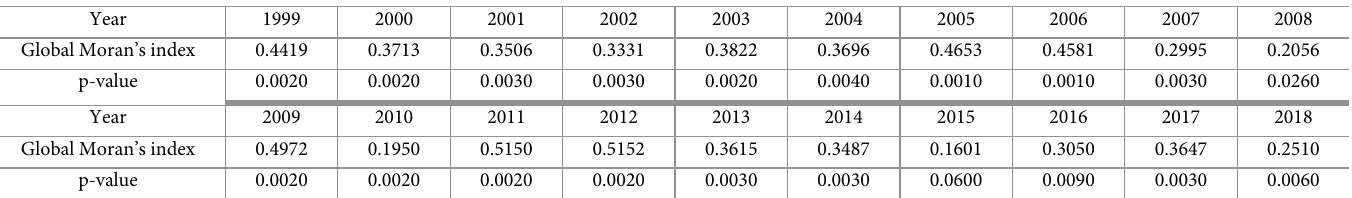
Table 6. Moran’s I of high-quality development of industry from 1999–2018.